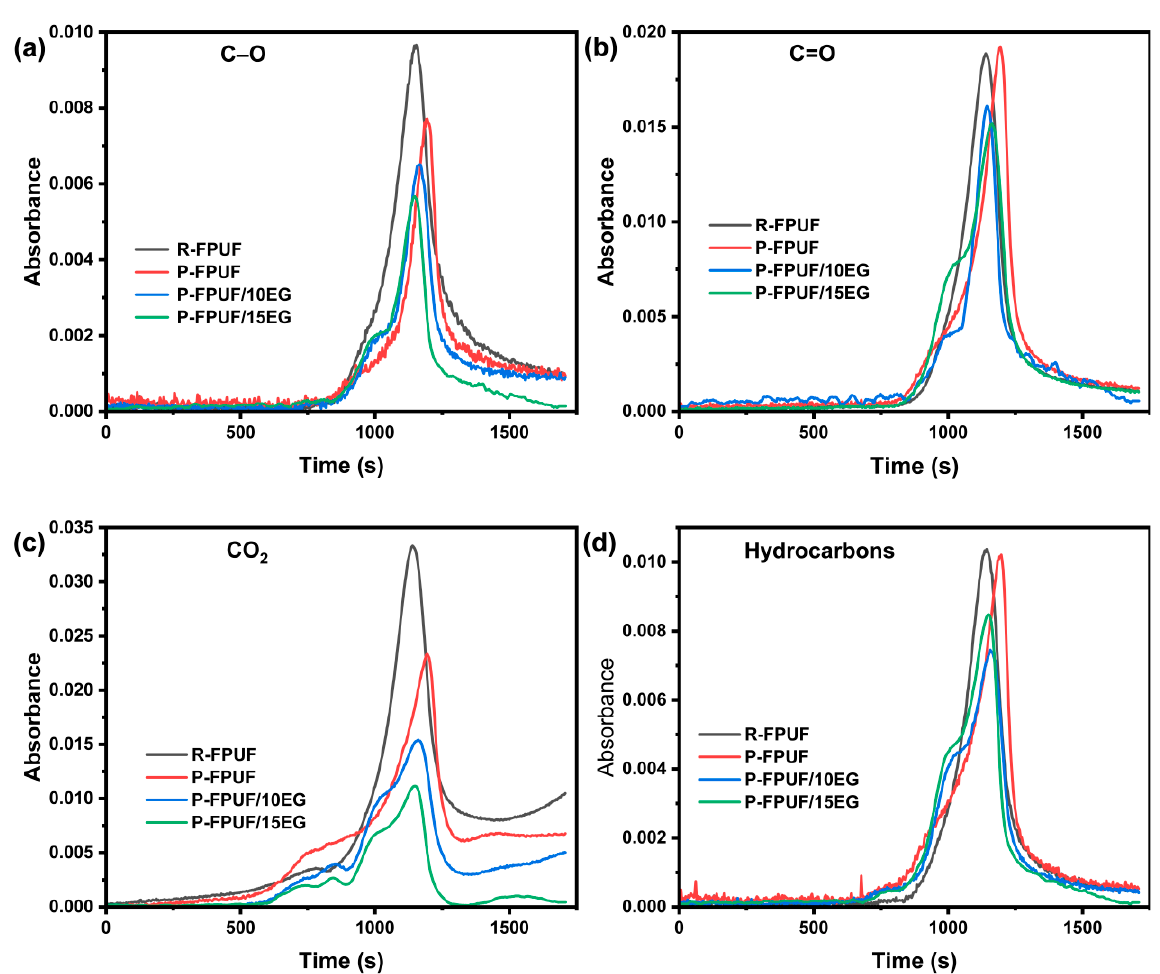
Figure 10. Intensities of absorption peaks for C ─ O ( a , e ), C=O ( b , f ), CO 2 ( c , g ) and hydrocarbons ( d , h ) of R-FPUF, P-FPUF, P-FPUF/10EG, and P-FPUF/15EG.